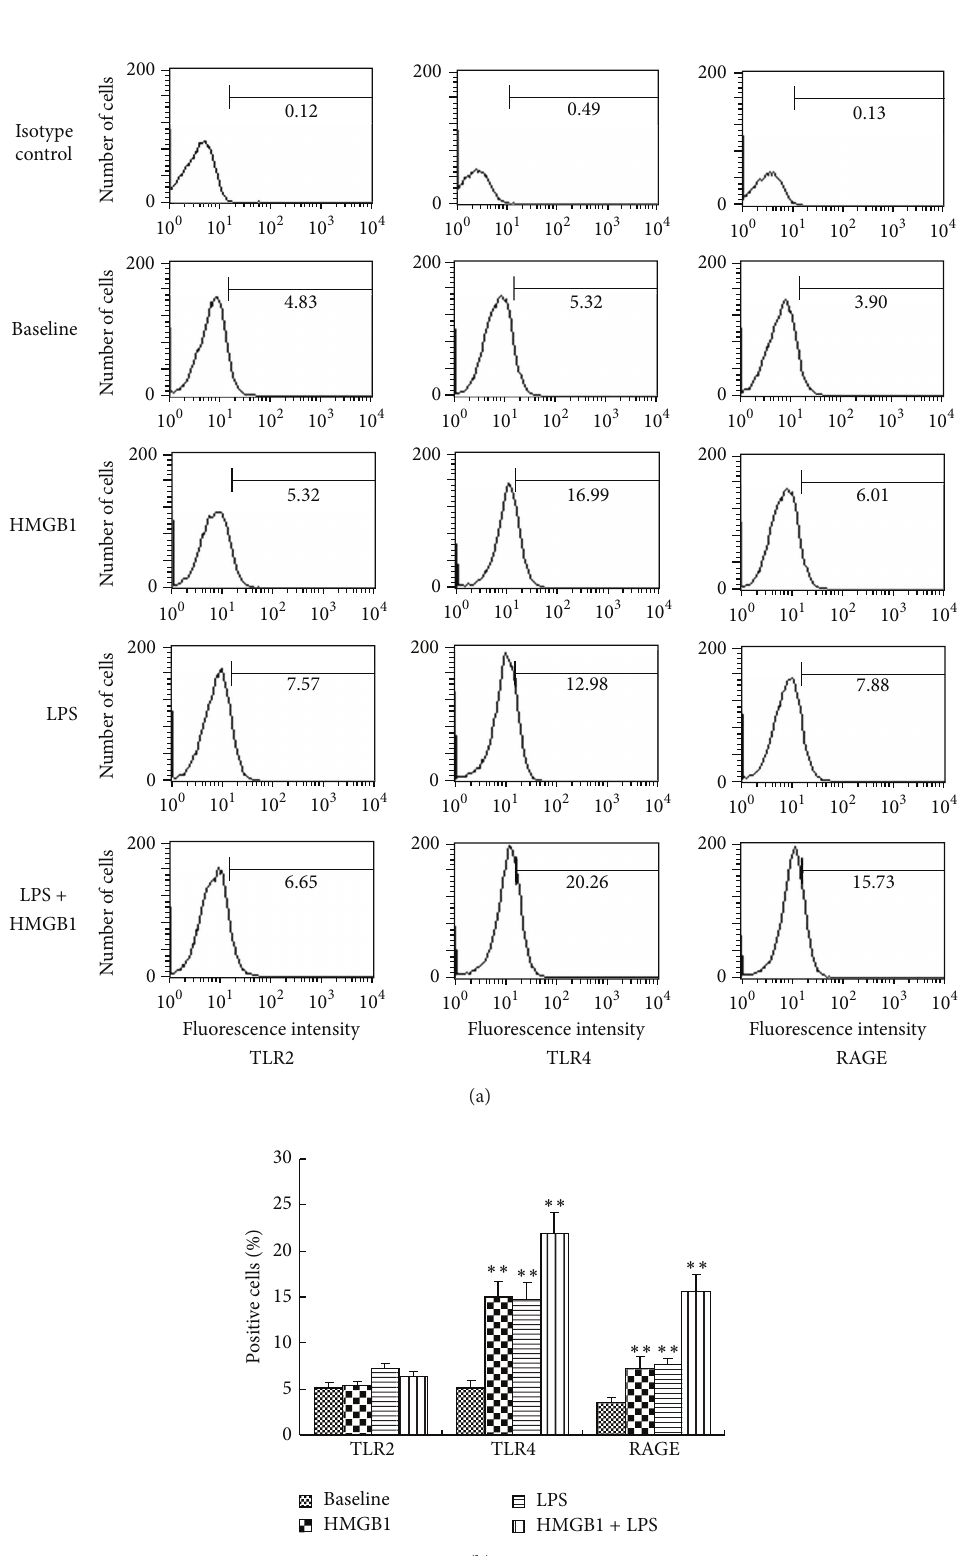
Figure 3: HMGB1 and LPS upregulated TLR2, TLR4, and RAGE expression on the surface of cultured SF. TLR: Toll-like receptor; RAGE: receptor for advanced glycation endproducts. SF were stimulated with 10ng/mL of LPS and/or 100ng/mL of HMGB1 for 24 h. The expression levels of molecules on the surface of SF were analyzed by flow cytometric analysis using specific antibodies. Representative histograms (a) and the percentages of the positive cells (b) were shown. Data are expressed as mean ± SD ( 𝑛 = 4 ). ∗ 𝑃 < 0.05 and ∗∗ 𝑃 < 0.01 compared with control (unstimulated